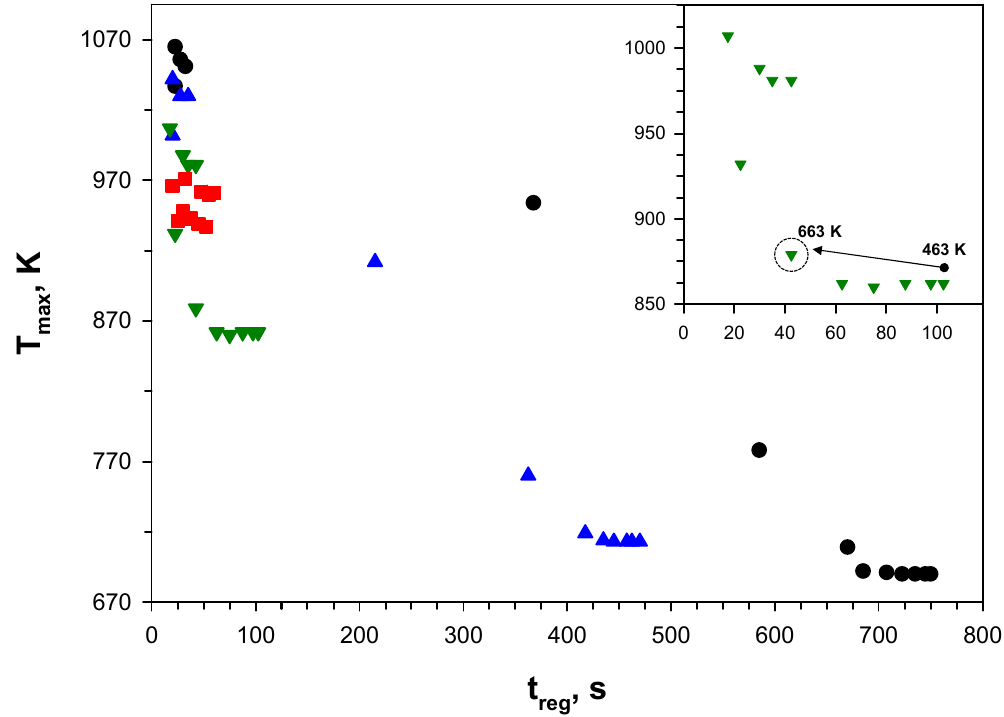
Figure 8. Operating map of a catalytic DPF in the plane T max versus t reg as built from simulations run by varying the initial temperature at di ff erent catalyst activities: ( • ) very low catalyst activity; ( (cid:78) ) low catalyst activity; ( (cid:72) ) intermediate catalyst activity; ( (cid:4) ) high catalyst activity. The inset highlights the operating map at intermediate catalyst activity. From [44].